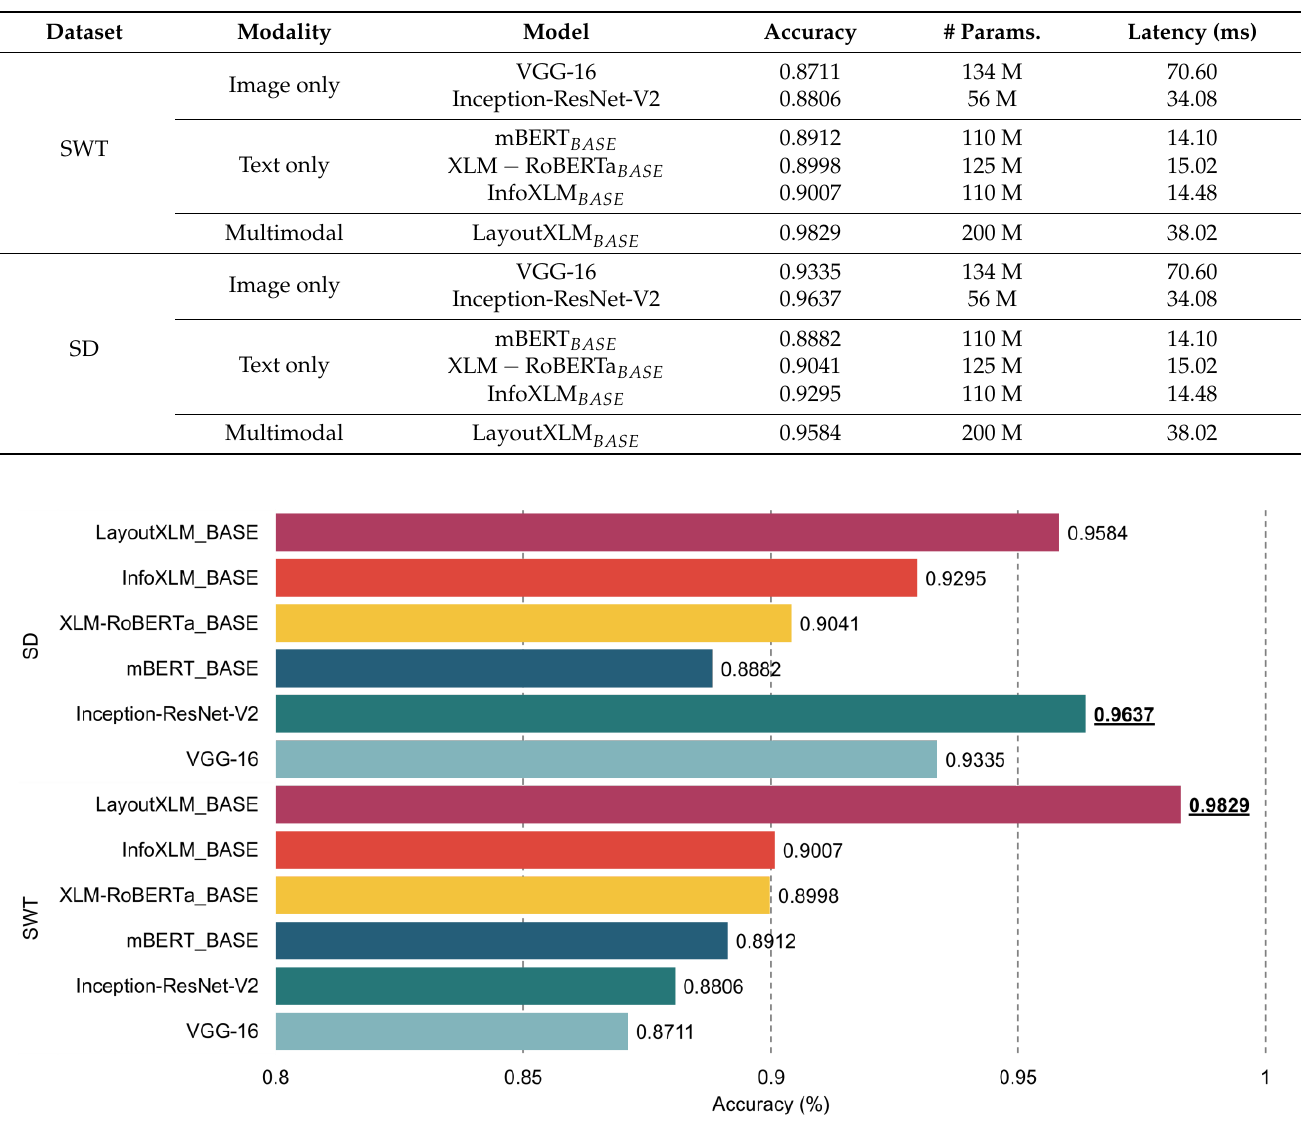
Table 4. Performance of document classification.